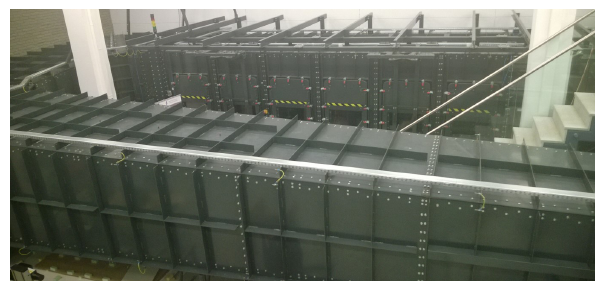
Figure 1. WUT Variable Turbulence